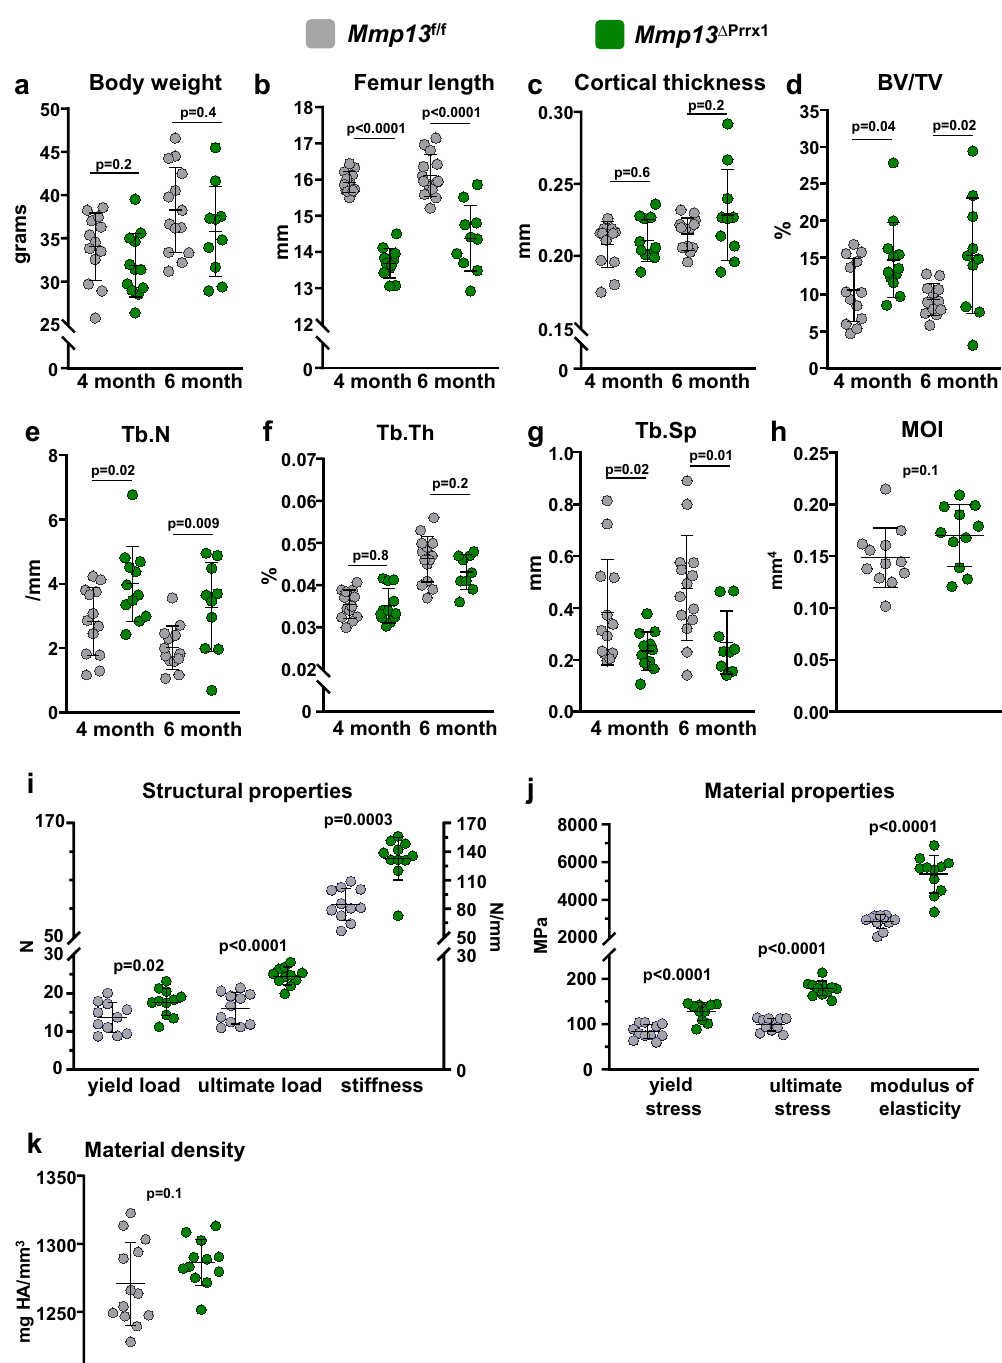
Figure 7. Mmp13 deletion in males increases trabecular bone mass and whole-bone strength. Male mice with Mmp13 deletion in Prrx1 expressing cells ( Mmp13 ΔPrrx1 ) and control littermates ( Mmp13f. /f ) where euthanized at 4 and 6 month of age. ( a ) Whole body weight and ( b ) femur length measured with a micrometer. ( c ) Cortical thickness at mid-shaft femur. ( d ) Trabecular bone volume and ( e – g ) microarchitecture at the distal metaphysis of the femur by micro-CT. ( h – j ) Three-point bending test in femurs from 4-month-old Mmp13f. /f and Mmp13 ∆Prrx1 male mice. ( h ) Moment of inertia, ( i ) structural properties of the femurs, including yield load, ultimate load and, stiffness, ( j ) material properties of the femurs, including yield stress, ultimate stress and modulus of elasticity. ( k ) Material density by micro-CT. Data represent mean ± S.D. (n = 14–10 mice/group); P values by student t